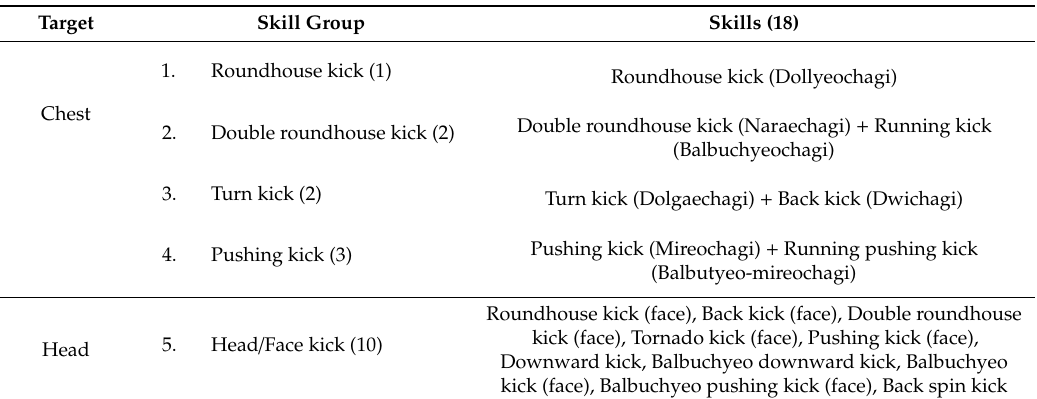
Table 2. Classification of Taekwondo